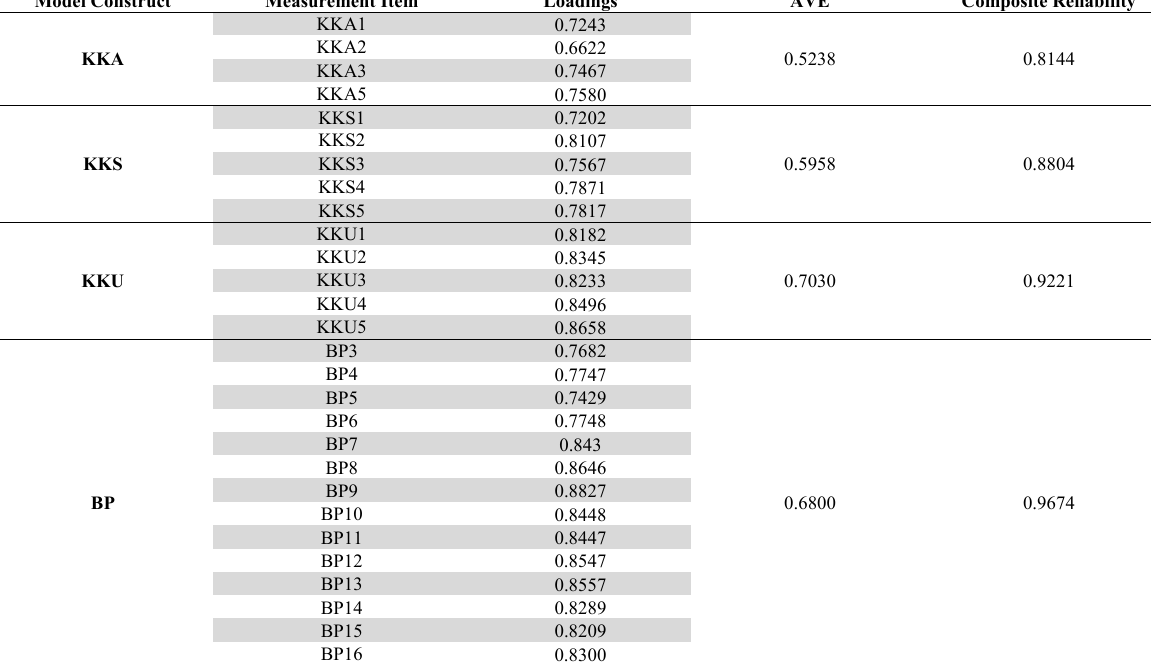
The Convergent Validity Assessment Results Model